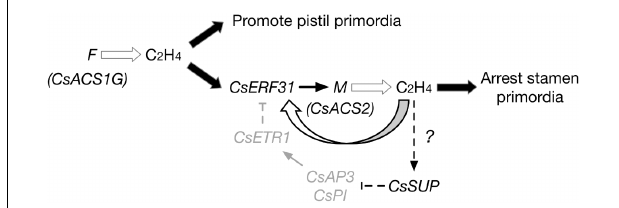
FIGURE 6 | Model of F and M functions during the differentiation of female flowers in gynoecious cucumber ( FFMMAA ). F produces ethylene, promotes pistil primordia development. CsERF31 responds to the ethylene signal and activates M . M begins its positive feedback activating expression via CsERF31 . The continuous accumulation of ethylene downregulates the B-class genes, CsAP3, and CsPI , by stimulating CsSUP in an unknown way. Thus, expression of CsETR1 is suppressed and fails to downregulate CsERF31 . This process constantly arrests the development of stamen primordia, resulting in the initiation of female